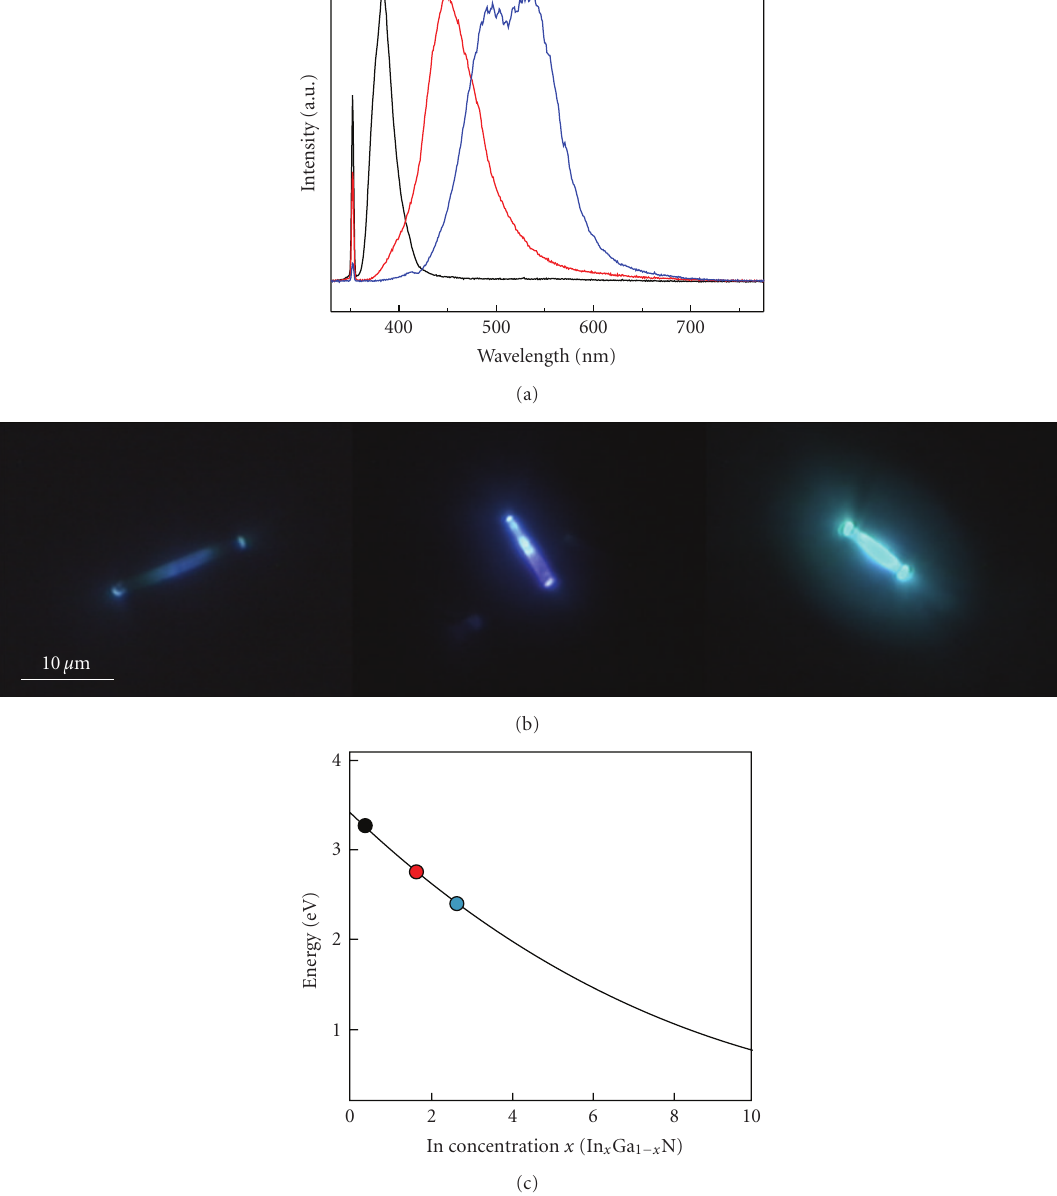
Figure 3: Photoluminescence of individual wires are shown. (a) PL spectra from left to right with peaks around 380, 450, and 525 nm. The images in (b) are the corresponding wires from the PL spectra in (a) arranged from left to right. (c) A plot of concentration versus bandgap energy shows the approximate concentration of the wire